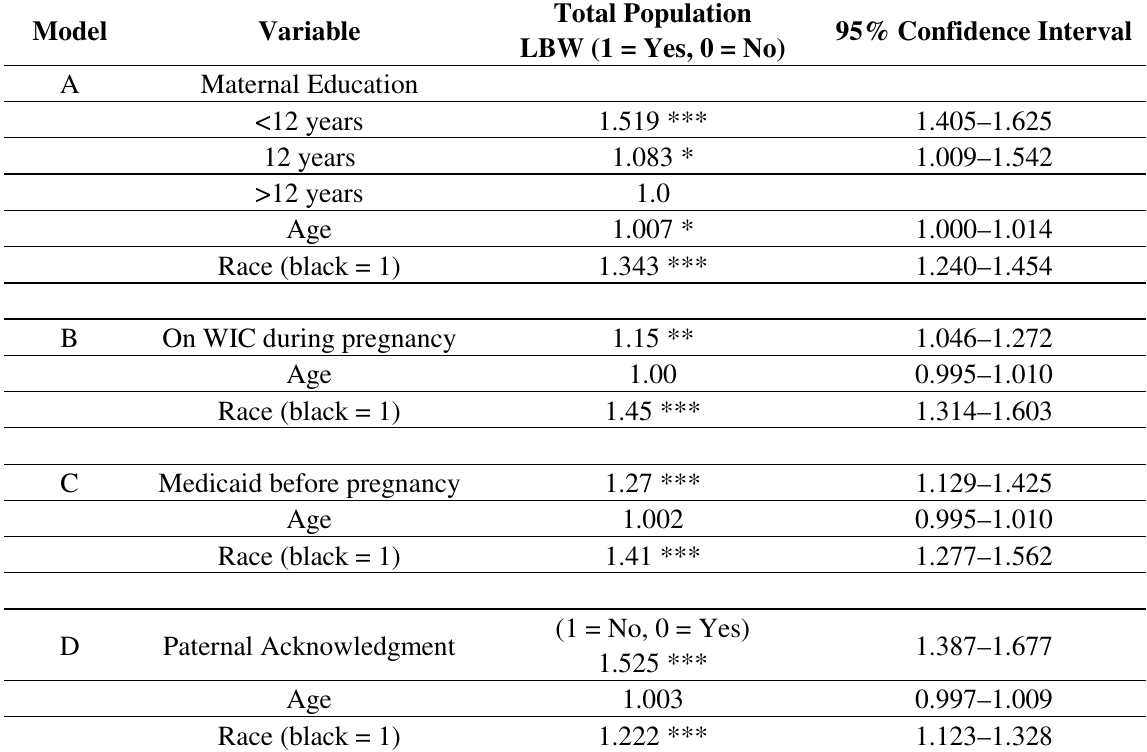
Table 2. Models representing odds ratios for socioeconomic position (SEP) measures and low birth weight (LBW) (total population).